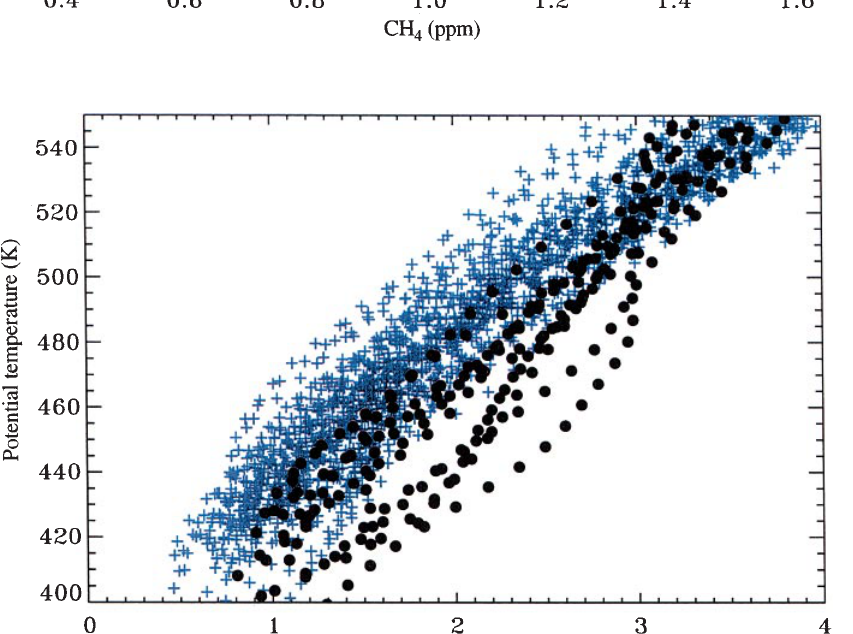
Fig. 10. HALOE measurements of the O 3 / CH 4 relationship in early November 1995. The complete set of sunset data for all November observations listed in Table 2 is shown. Measurements inside the vortex are shown as black circles, outside measurements are shown as blue plus signs. Overplotted in red is the early vortex relation (Eq. 1)